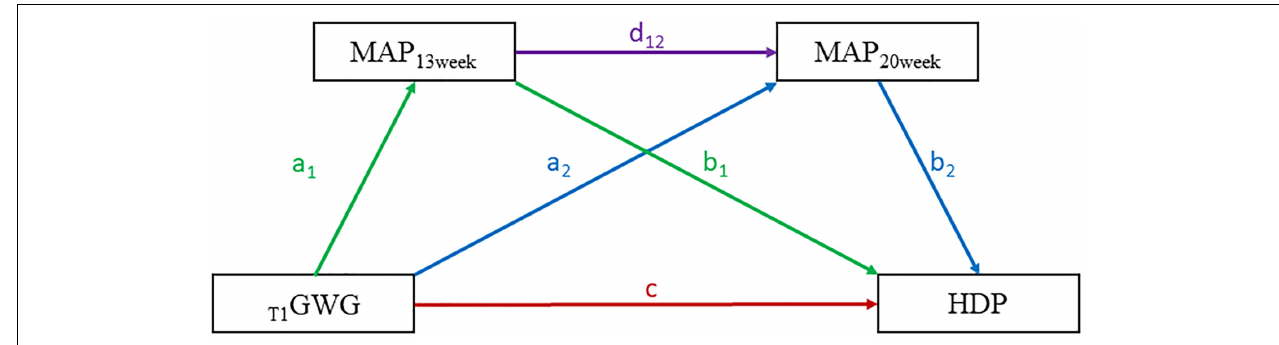
FIGURE 2 | The serial mediation pattern of the association between first-trimester GWG ( T 1 GWG) and hypertensive disorders of pregnancy (HDP). The respective colorful lines represent the different pathways of the T 1 GWG effects on HDP. The direct effect (DI) of T 1 GWG on HDP was presented by red line. The indirect effect (IE) of T 1 GWG to MAP 13 week to HDP was presented by green lines. The IE from T 1 GWG to MAP 13 week to MAP 20 week to HDP was presented by purple lines. The IE of T 1 GWG to MAP 20 week to HDP was presented by blue lines. The serial mediation equation included three parts: (1). MAP 13 week ∼ a 1 ∗ T 1 GWG + covariables. (2) MAP 20 week ∼ a 2 ∗ T 1 GWG + d 12 ∗ MAP 13 week + covariables. (3) HDP ∼ c ∗ T 1 GWG + b 1 ∗ MAP 13 week + b 2 ∗ MAP 20 week + covariables. And the c was defined as the DI from T 1 GWG to HDP, the mediation effects were expressed as follows: (1) IE 1 ( T 1 GWG to MAP 13 week to HDP) = a 1 ∗ b 1 . (2) IE 2 ( T 1 GWG to MAP 20 week to HDP) = a 2 ∗ b 2 . (3) IE 3 ( T 1 GWG to MAP 13 week to MAP 20 week to HDP) = a 1 ∗ d 12 ∗ b 2